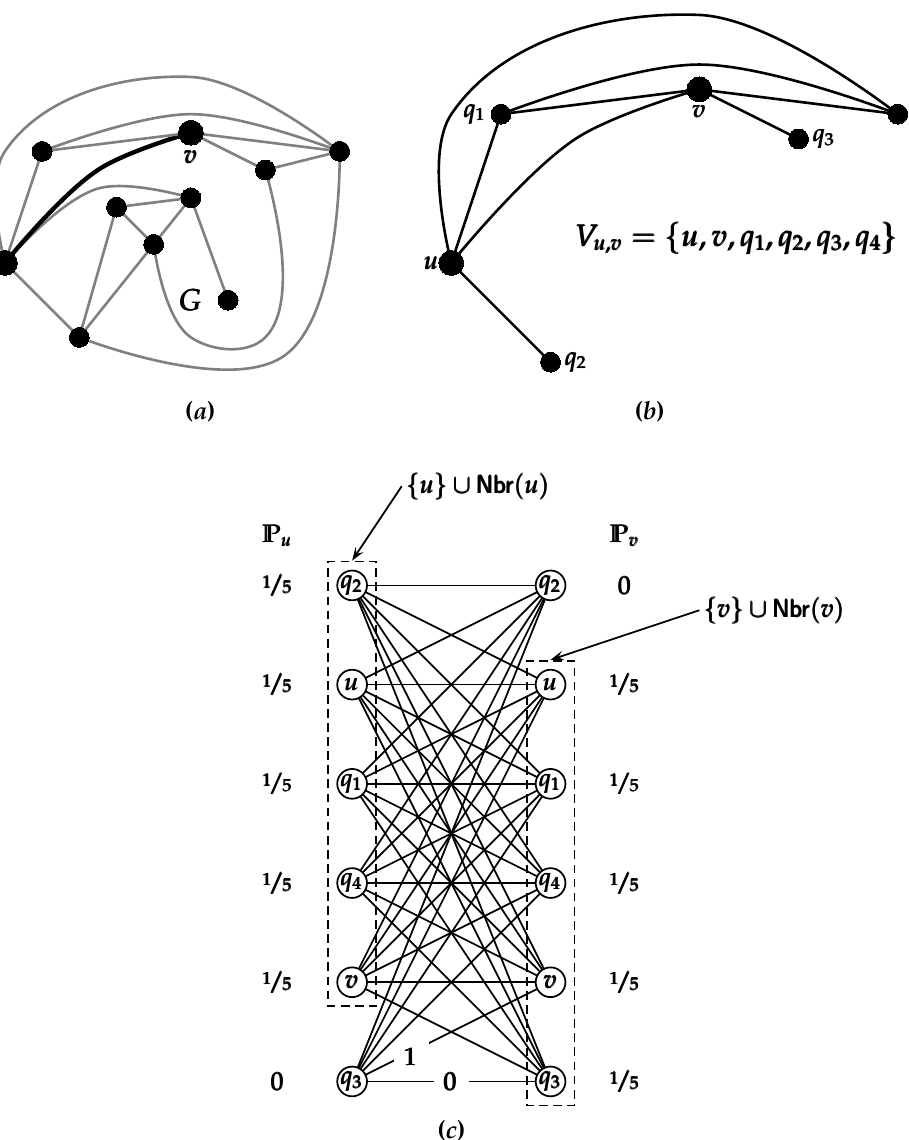
Figure 2. A pictorial illustration of calculation of R IC ( u , v ) . ( a ) The given graph G ; ( b ) The subset of nodes V u , v ; ( c ) The distributions P u and P v . For visual clarity, only two distances dist ( q 3 , q 3 ) = 0 and dist ( v , q 3 ) = 1 are